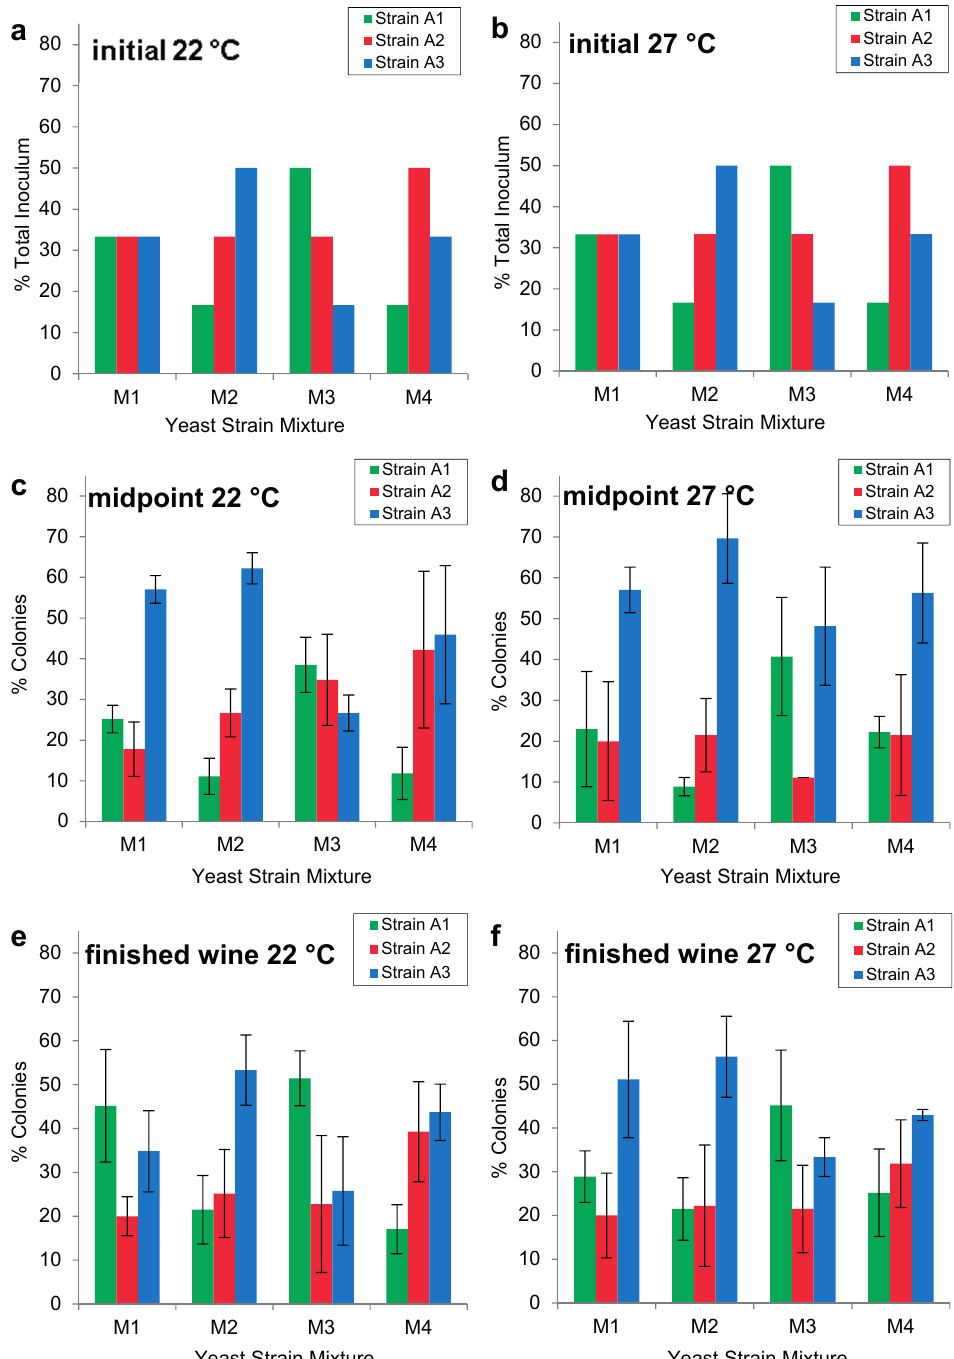
Figure 2. Initial inoculation ratios of Pinot noir fermentations co-cultured with Burgundian isolates (A1, A2, A3) in mixtures M1 (1:1:1), M2 (1:2:3), M3 (3:2:1), and M4 (1:3:2) at ( a ) 22 °C and ( b ) at 27 °C. Mixed strain populations at the midpoint (~6.0% v/v ethanol) ( c ) at 22 °C and ( d ) 27 °C and end of fermentation (~13.5% v/v ethanol) ( e ) at 22 °C and ( f ) at 27 °C. Yeast populations were quantified using colony PCR in conjunction with δ sequence typing on 45 colonies for each of three biological